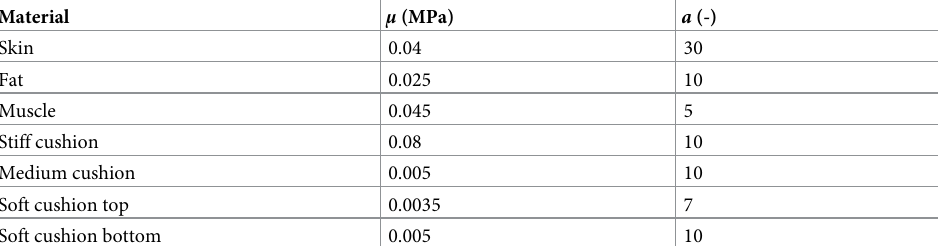
Table 1. Parameters for the Ogden material model for each of the materials modelled. Ogden strain energy